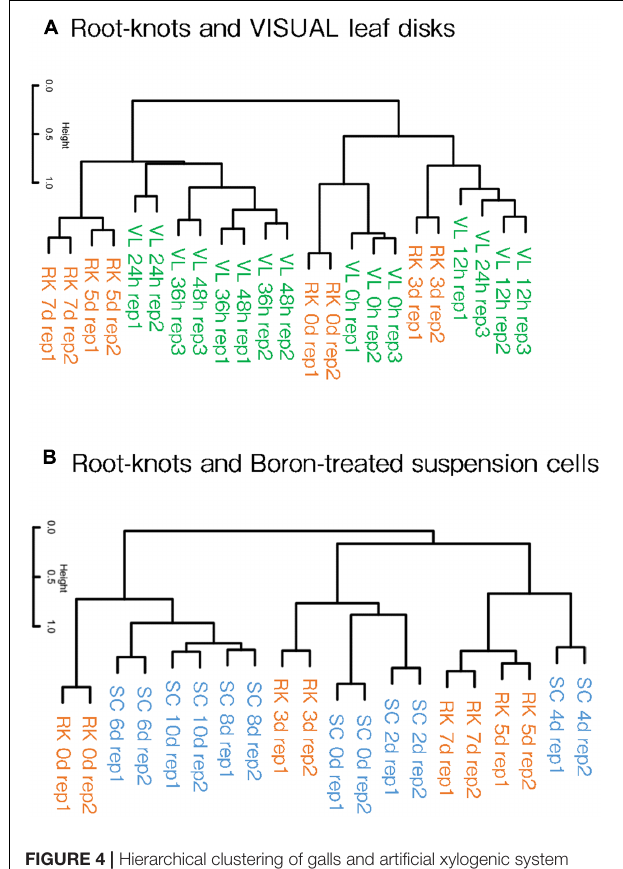
FIGURE 4 | Hierarchical clustering of galls and artificial xylogenic system global expression profiles. Comparison of gall and VISUAL leaf disk transcriptome profiles published by Kondo et al. (2015), (A) and boron-treated xylem induction system published by Kubo et al. (2005) (B) . The complete data of the GEO accessions are shown in Supplementary Table S1